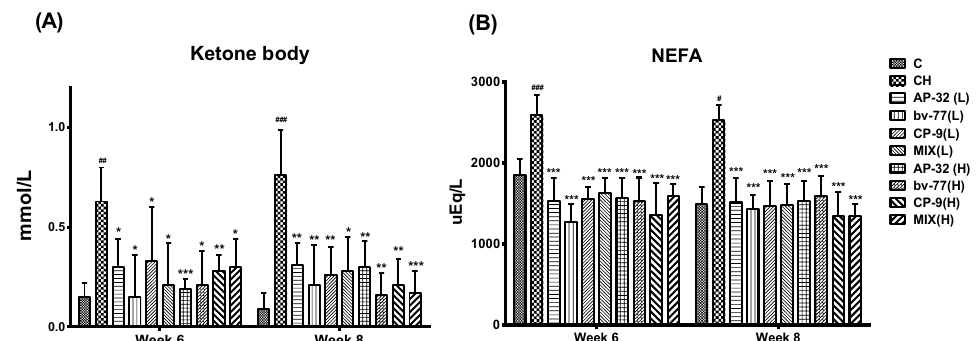
Figure 2. Serum levels of ketone bodies and NEFA in response to probiotic treatments. SD rats were fed a high-fat diet to induce obese symptoms from week 1 to week 8, and probiotic treatments were administered from week 5 to week 8. Obese rats were treated with a single probiotic strain or a mixture of three strains at a low or high (L = 5 × 10 9 CFU/kg/day, H = 2.5 × 10 10 CFU/kg/day) dosage daily for 4 weeks. The levels of ( A ) ketone bodies (mmol/L) and ( B ) NEFA (uEq/L) were presented at weeks 6 and 8. Data are shown as the mean ± S.D. Statistical analysis was performed by using a one-way ANOVA. Statistical difference was compared between the C and CH groups ( # p < 0.05, ## p < 0.01, ### p < 0.001), or between the CH and a probiotics-treated group (* p < 0.05, ** p < 0.01, and *** p < 0.001). NEFA: nonesterified fatty acids; C: control; CH: symptom control; MIX: probiotic mixture of AP-32, bv-77, and